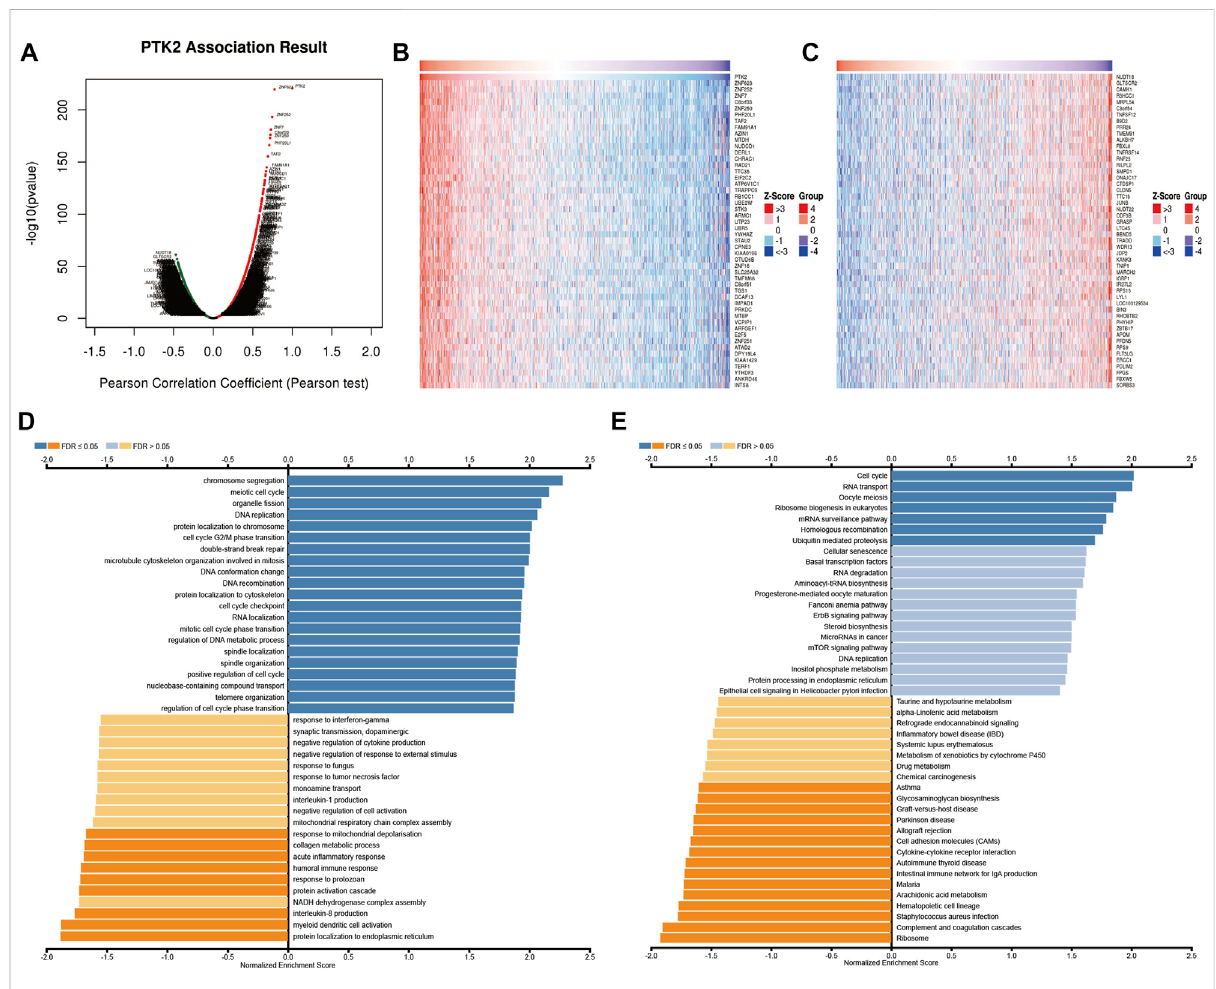
FIGURE 5 PTK2 co-expressed genes and functional enrichment analysis (LinkedOmics). (A) Volcano plot of co-expressed pro fi ling of PTK2 in breast cancer; red (positive) and green (negative). (B,C) Heat maps showing the top 50 positively and 50 negatively correlated genes with PTK2 in breast cancer. The BP (D) and KEGG (E) of PTK2 were analyzed by